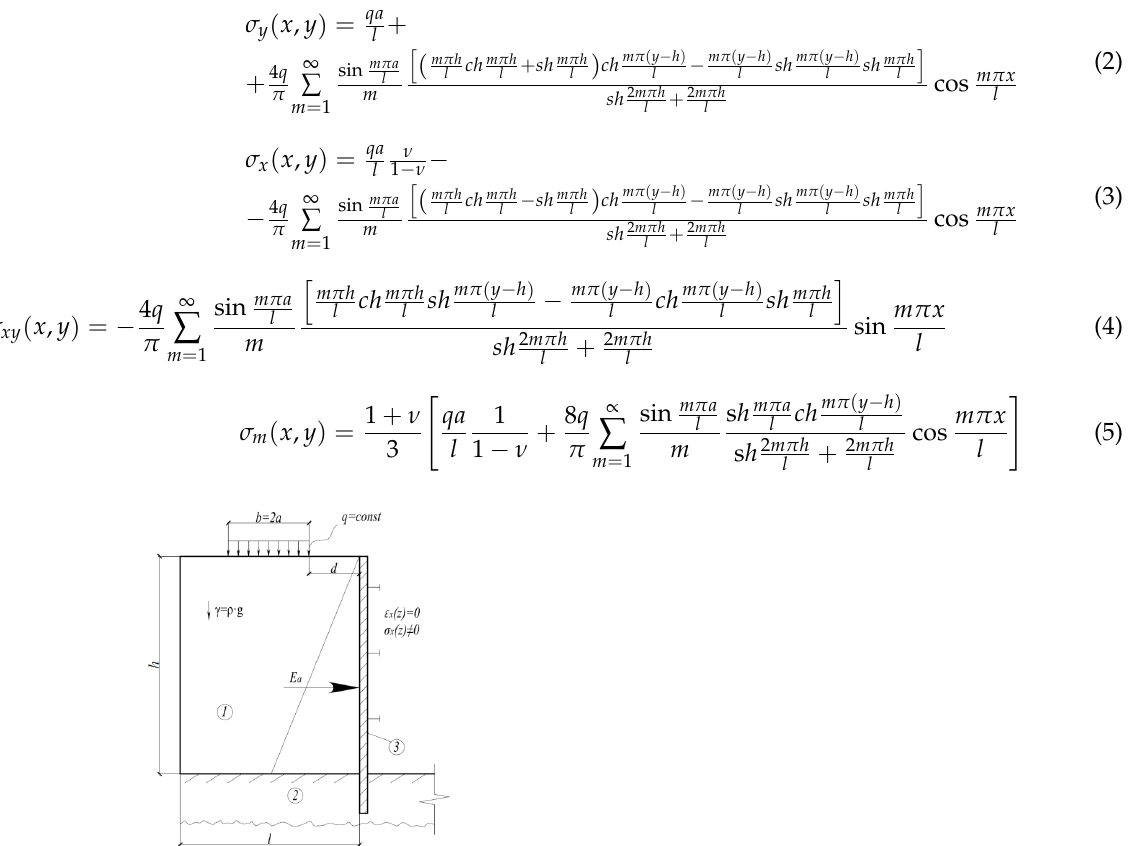
Figure 2. Design scheme for the interaction of a weighty layer (1) with thickness (h) resting upon an incompressible soil base (2) with a vertically fixed retaining wall (3) under a distributed load q = const along the strip b = 2a at a distance d from the retaining wall.